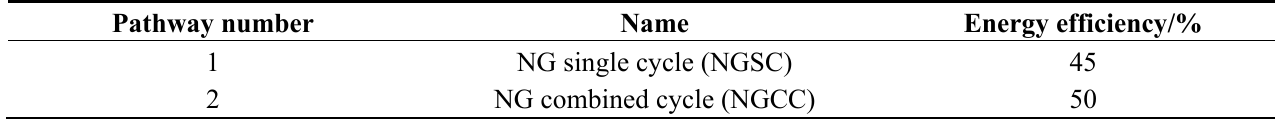
Table 7. Basic parameters of NG-based electricity